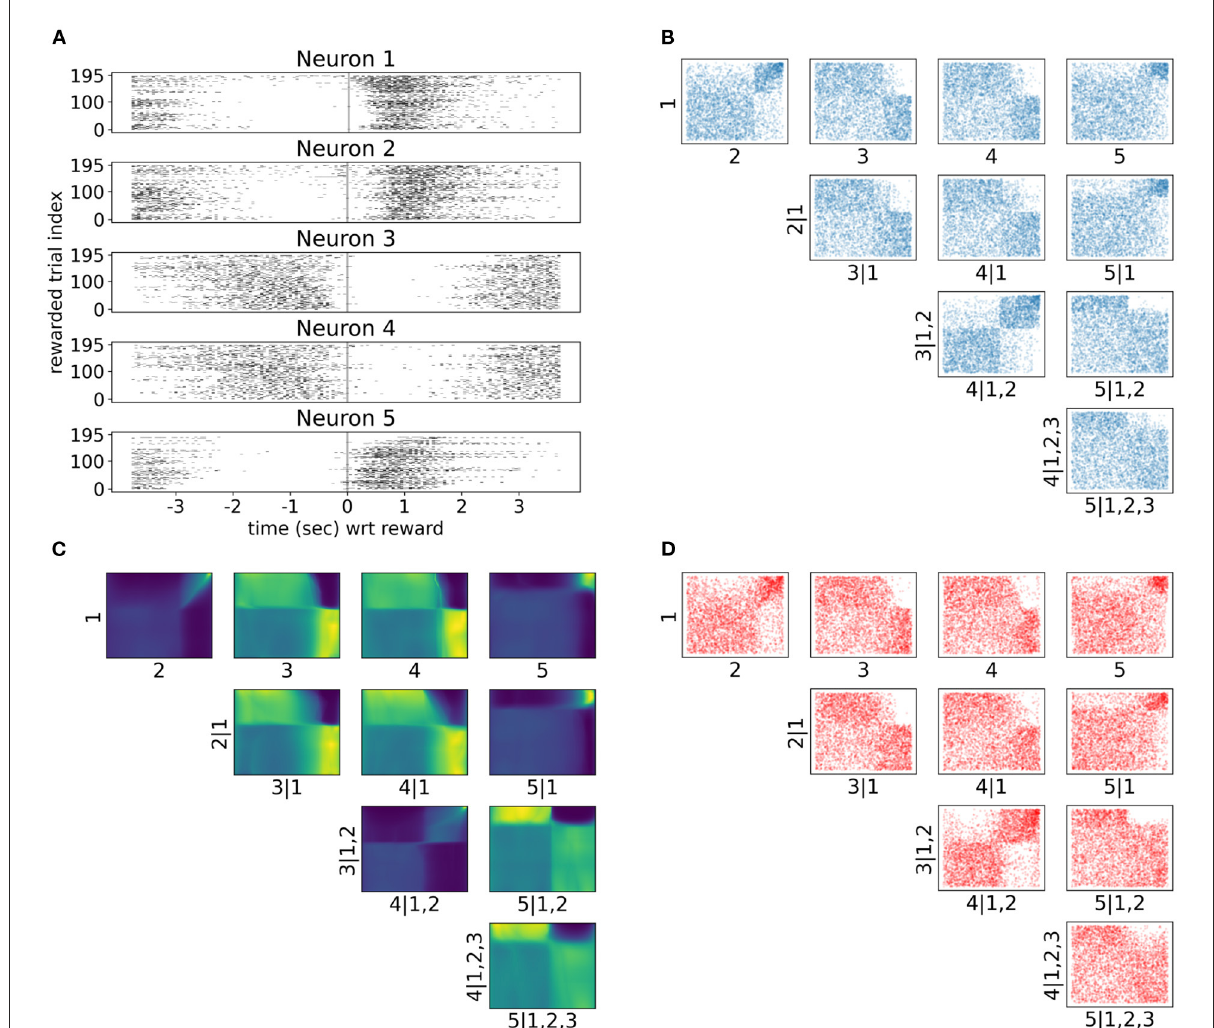
FIGURE7 Tail dependencies in time dependent V1 activity are captured by NSF vine copulas. (A) Raster plots for same five neurons in V1 rodent data across trials and time with respect to reward (3.5 s before until 3.5 s after reward) in the virtual corridor. Gray vertical line denotes reward acquisition. (B) Scatter plots of empirical copula samples (blue dots) from the 5-D vine. All other conventions are the same with Figure 6. (C) Copula densities of the 5-D vine from the trained NSF. (D) Simulated samples (red dots) from the trained NSF copula densities of the 5-D vine.